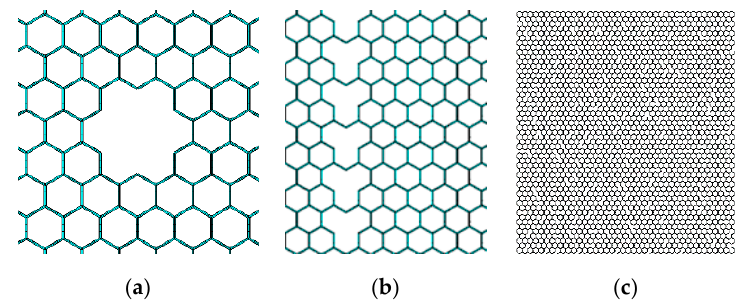
Figure 4. Graphene with vacancy defects. ( a – c ) are for center concentrated, periodic, and random distributed vacancy defects, respectively.